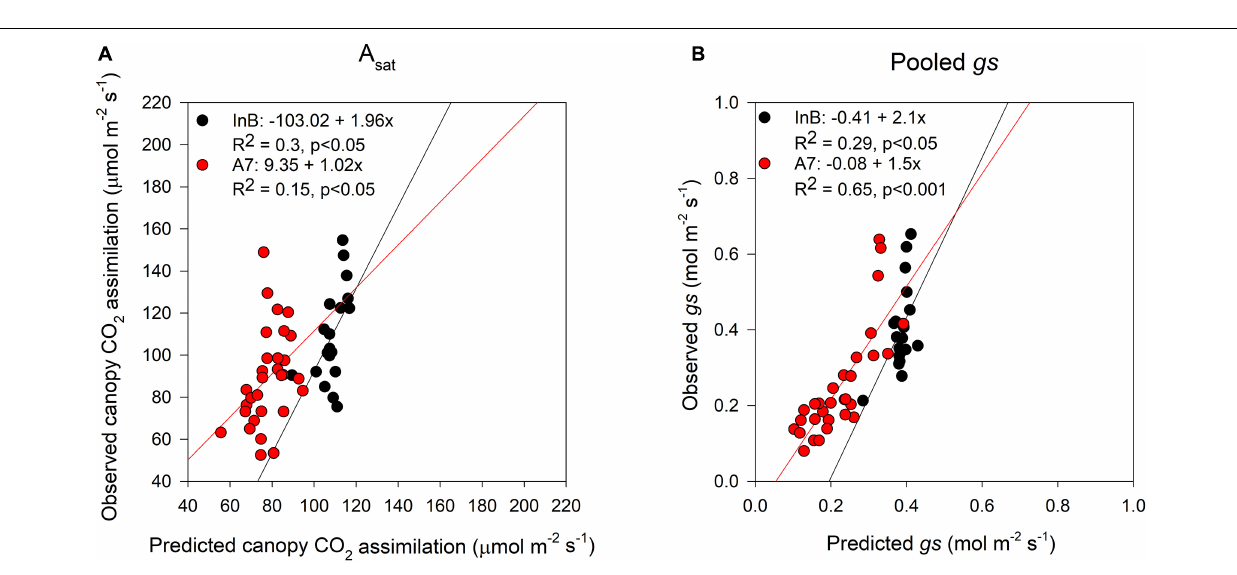
FIGURE 6 | Comparison between predictions ( X -axis) and ground truth data ( Y -axis) of canopy assimilation (A) and stomatal conductance (B) . Black dots represent data from initiation of booting and red dots data from 7 days after anthesis. Data shown are the observed vs predicted bilinear unbiased estimator (BLUEs) in 2 years of study (initiation of booting, n = 19) and 3 years of study (7 days after anthesis, n = 30). Lines represent the linear regression when statistically significant relationships were